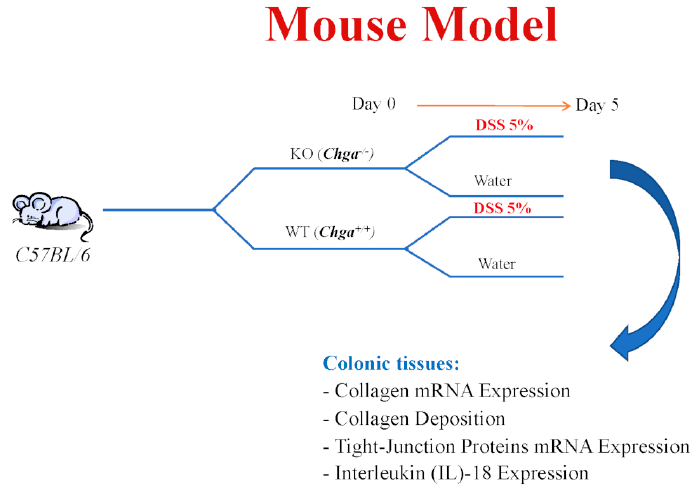
Figure 10. Mouse model: Experimental design.